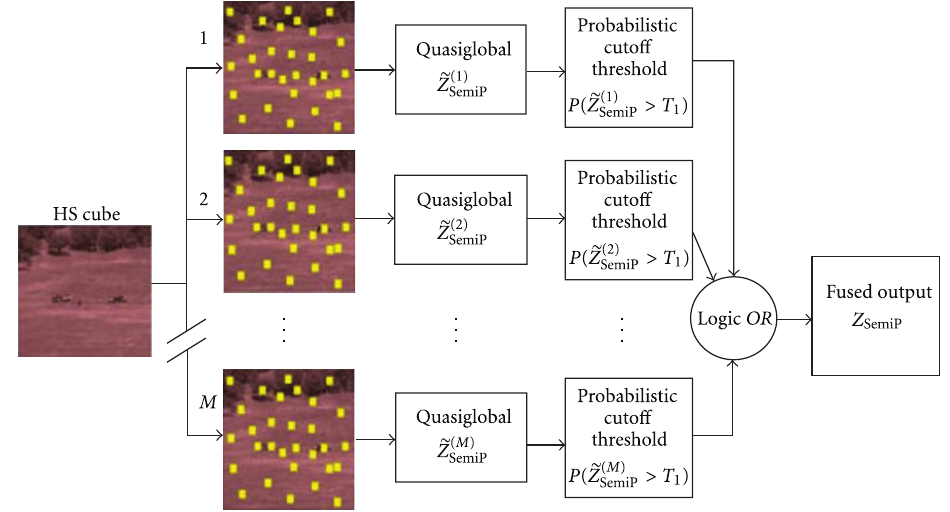
Figure 8: Quasiglobal, semiparametric anomaly detection